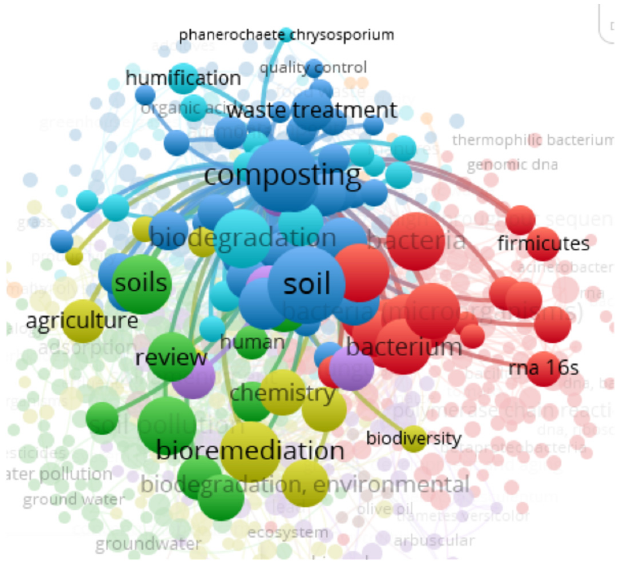
Figure 16. Composting association: bioremediation, chemistry and biodiversity (yellow circles).